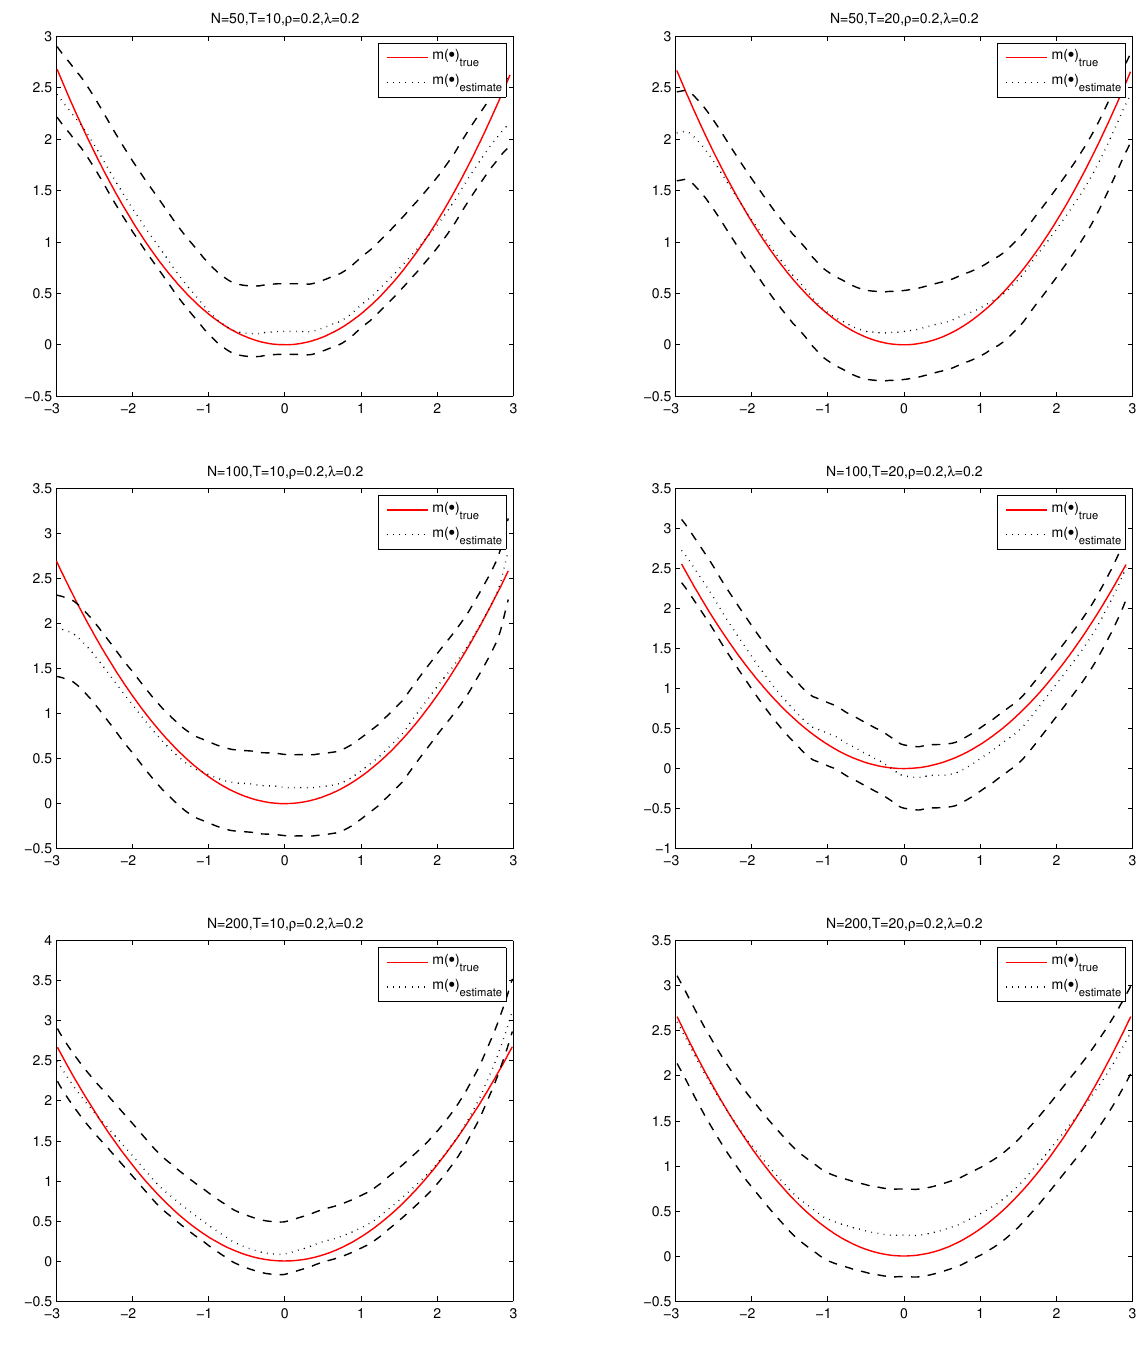
m( • ) true m( • ) estimate